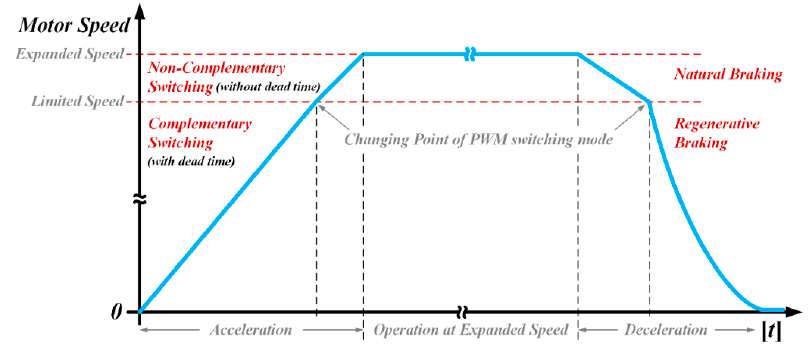
Figure 5. Expanded operating range of the high-speed BLDC motor using proposed control algorithm.